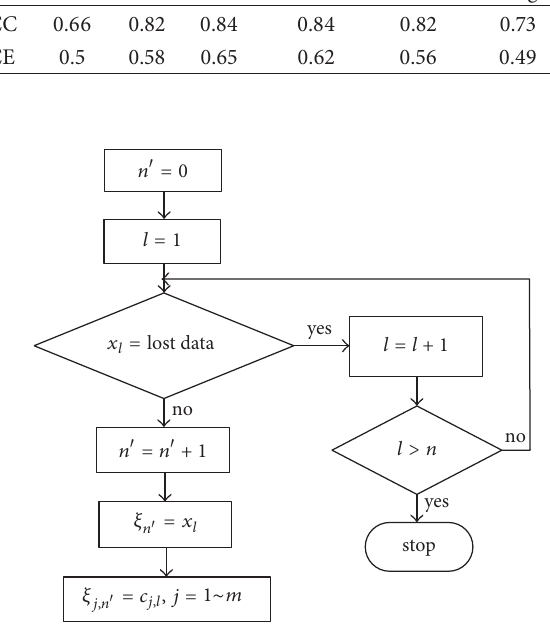
Figure 3: Flow chart of vector transform when data missing